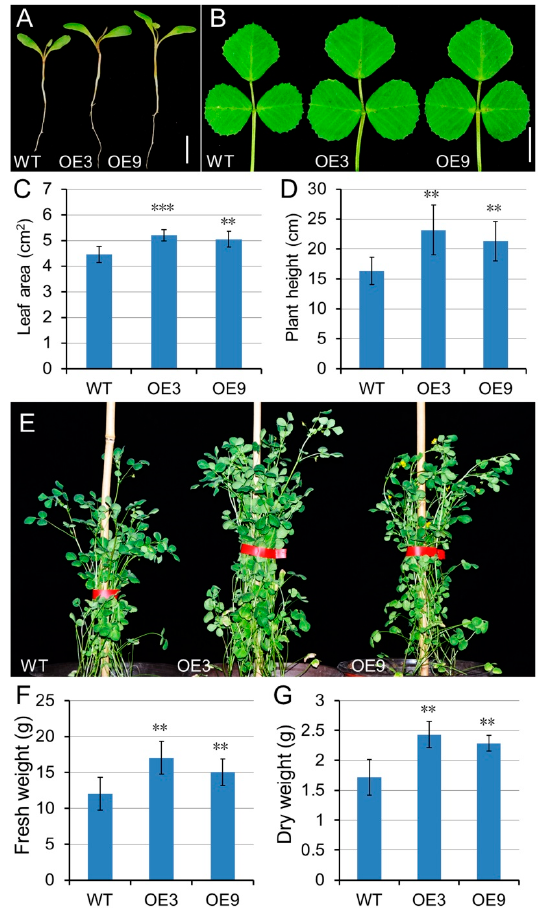
Figure 9. Overexpression of MtGA20OX1 promoted biomass production. ( A , B ) The cotyledeon and leaf phenotypes of the wild type and MtGA20OX1 transgenic lines. ( C ) Measurements of the blade area of compound leaves on the fifth node of 4-week-old WT and MtGA20OX1 transgenic plants (means ± SD; n = 5). ( D ) The plant height of MtGA20OX1 transgenic and wild type plants within 50 days (means ± SD; n = 13). ( E ) Morphology of wild-type (WT) and MtGA20OX1 overexpressing M. truncatula plants. ( F , G ) The fresh and dry weight of developing wild type and MtGA20OX1 transgenic plants (means ± SD; n = 10). Bars = 1 cm in A and B. ** p < 0.01, *** p < 0.001.